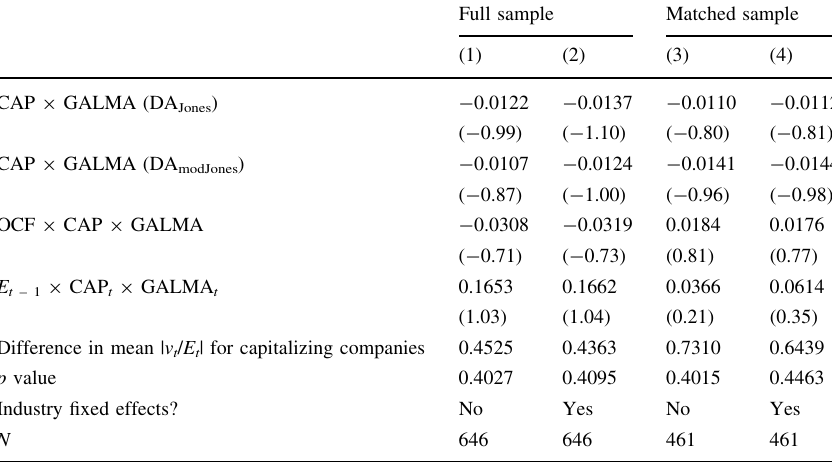
Table 12 Results of financial reporting properties for the subsample of companies with R&D